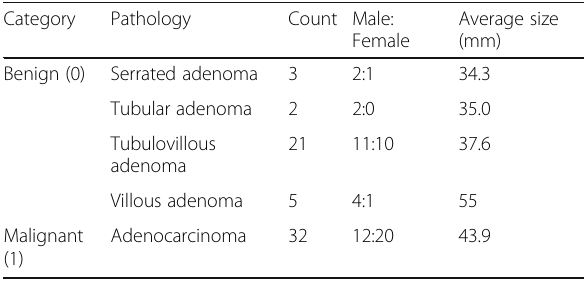
Table 2 Summary of ployp mass for dataset